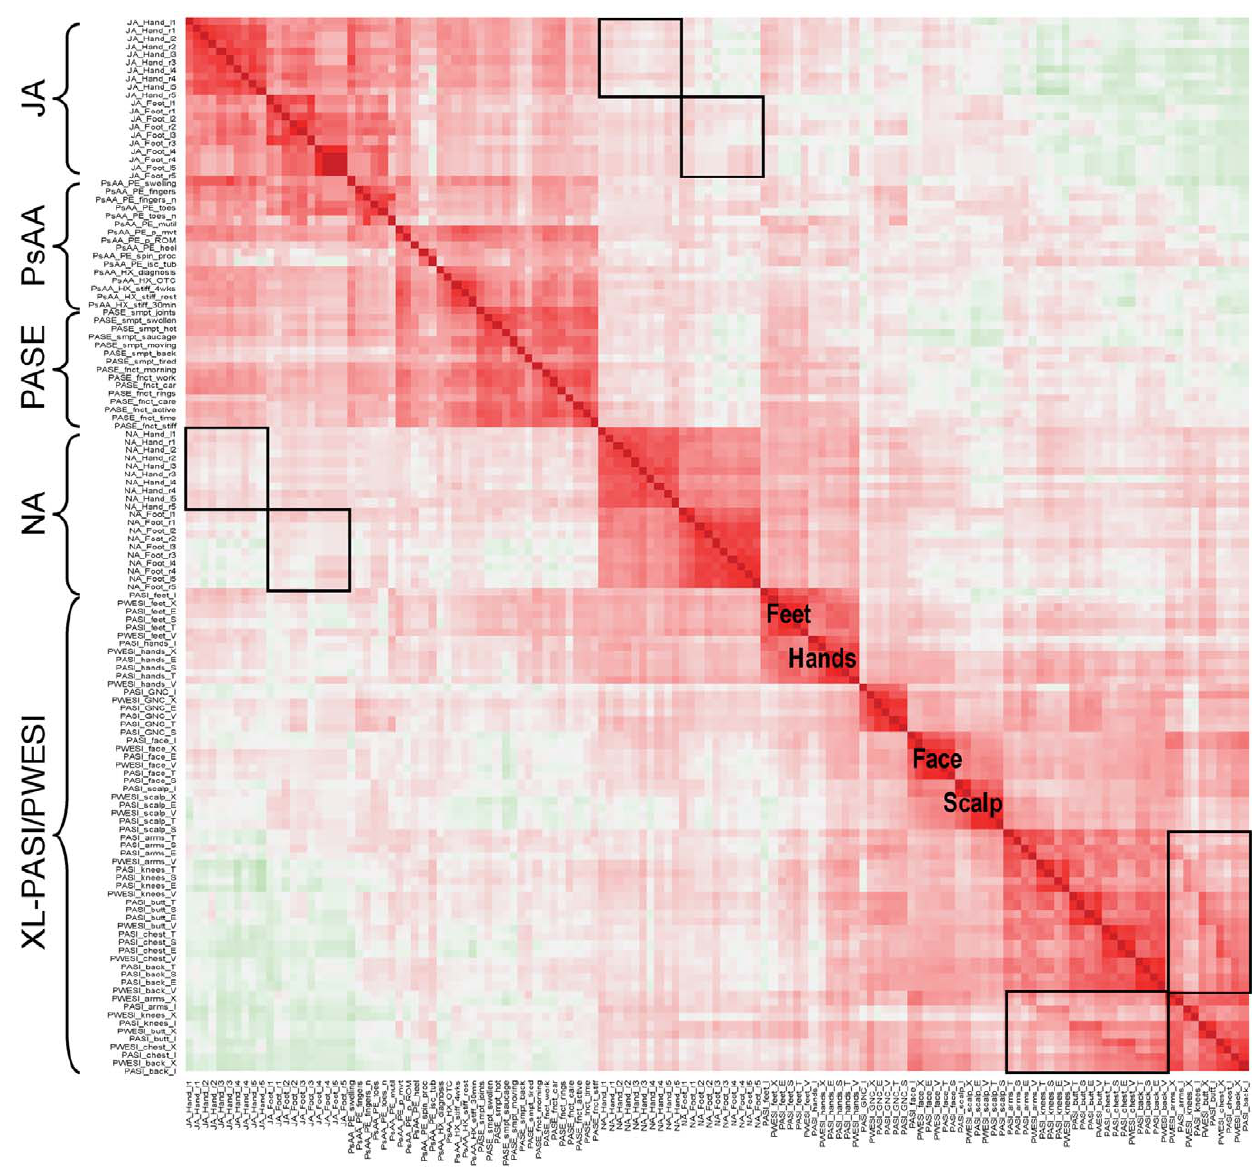
Figure 2. Correlations between individual items of psoriasis and psoriatic arthritis severity. Each cell indicates the Spearman correlation between 2 of the 52 items. Cells with dark red indicates strong positive correlation, light red indicates weak positive correlation, dark green indicates strong negative correlation, and light green indicates weak negative correlation. Boxes in the upper left portion indicate correlations between affected nails and joints on hands and feet. Boxes in the lower right corner indicate ‘‘secondary structure’’ (within-box diagonal) between extent/ involvement and severity/activity within regions. JA: Joint Assessment; NA: Nail Assessment; PASE: Psoriatic Arthritis Screening and Evaluation Questionnaire; PsAA: Psoriatic Arthritis Assessment; XL-PASI: Extended 10-area Linear Psoriasis Area and Severity Index; PWESI: Psoriasis Weighted Extent and Severity Index.